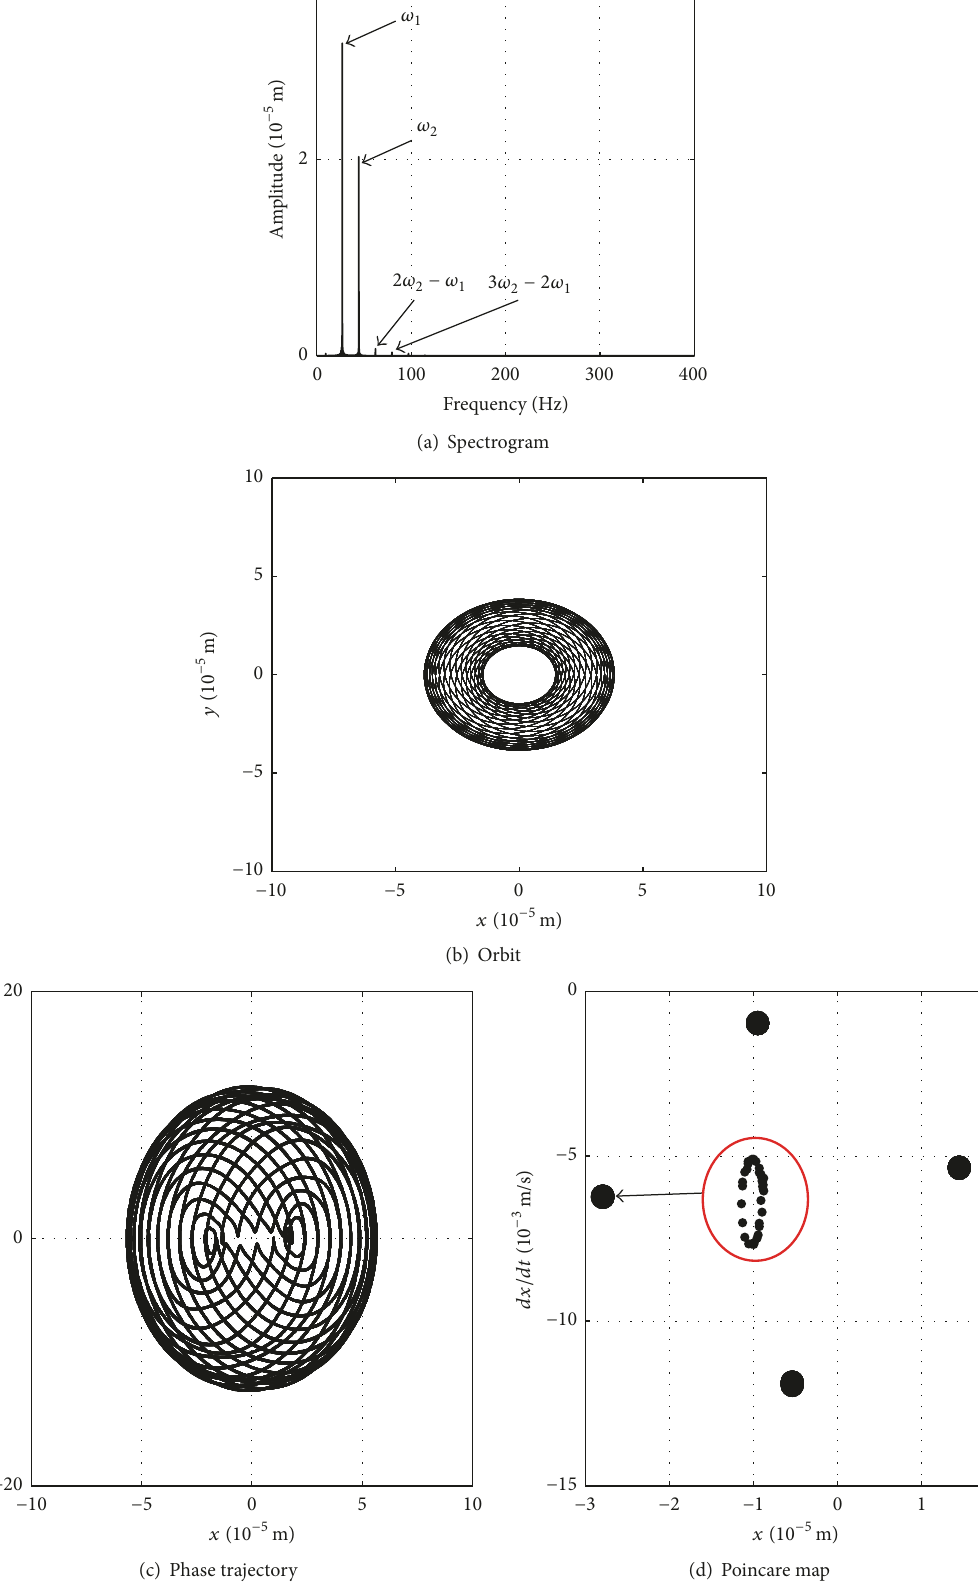
Figure 17: Response analysis of disk 2: 𝜔 1 = 170 rad / s and 𝜆 = 1.65